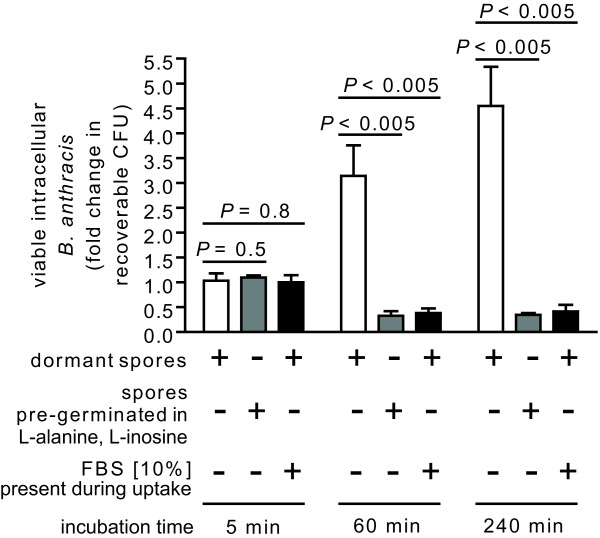
The germination state of spores influences the viability of intracellular B. anthracis. RAW264.7 cells were incubated for 30 min with dormant B. anthracis spores (MOI 10) in DMEM in the presence (+, black bars) or absence (-, white bars) of FBS (10%), or, with pre-germinated spores (MOI 10) in DMEM in the absence of FBS (grey bars). B. anthracis spores were pre-germinated by incubation for 30 min in PBS pH 7.2 supplemented with L-alanine and L-inosine (both at 10 mM), and then washed twice with PBS pH 7.2 to remove germinants. After 30 min, the cells were washed to remove extracellular B. anthracis, and then further incubated with FBS (10%) and, as described under "Methods," with gentamicin to germinate and kill any remaining spores that had not been germinated. After 15 min, the cells were washed and then further incubated in the absence of gentamicin. At 5, 60, or 240 min after removal of gentamicin, as indicated, the RAW264.7 cells were lysed, and the lysates were evaluated for viable B. anthracis, as described under Materials and Methods. The data were rendered as the fold-change in recoverable CFU in the absence or presence of FBS, relative to cells at 5 min post infection in the absence of FBS. The rendered data were combined from three independent experiments, each conducted in triplicate. Error bars indicate standard deviations. The P values were calculated to evaluate the statistical significance of the differences in recoverable CFU between cells infected in the absence or presence of FBS.